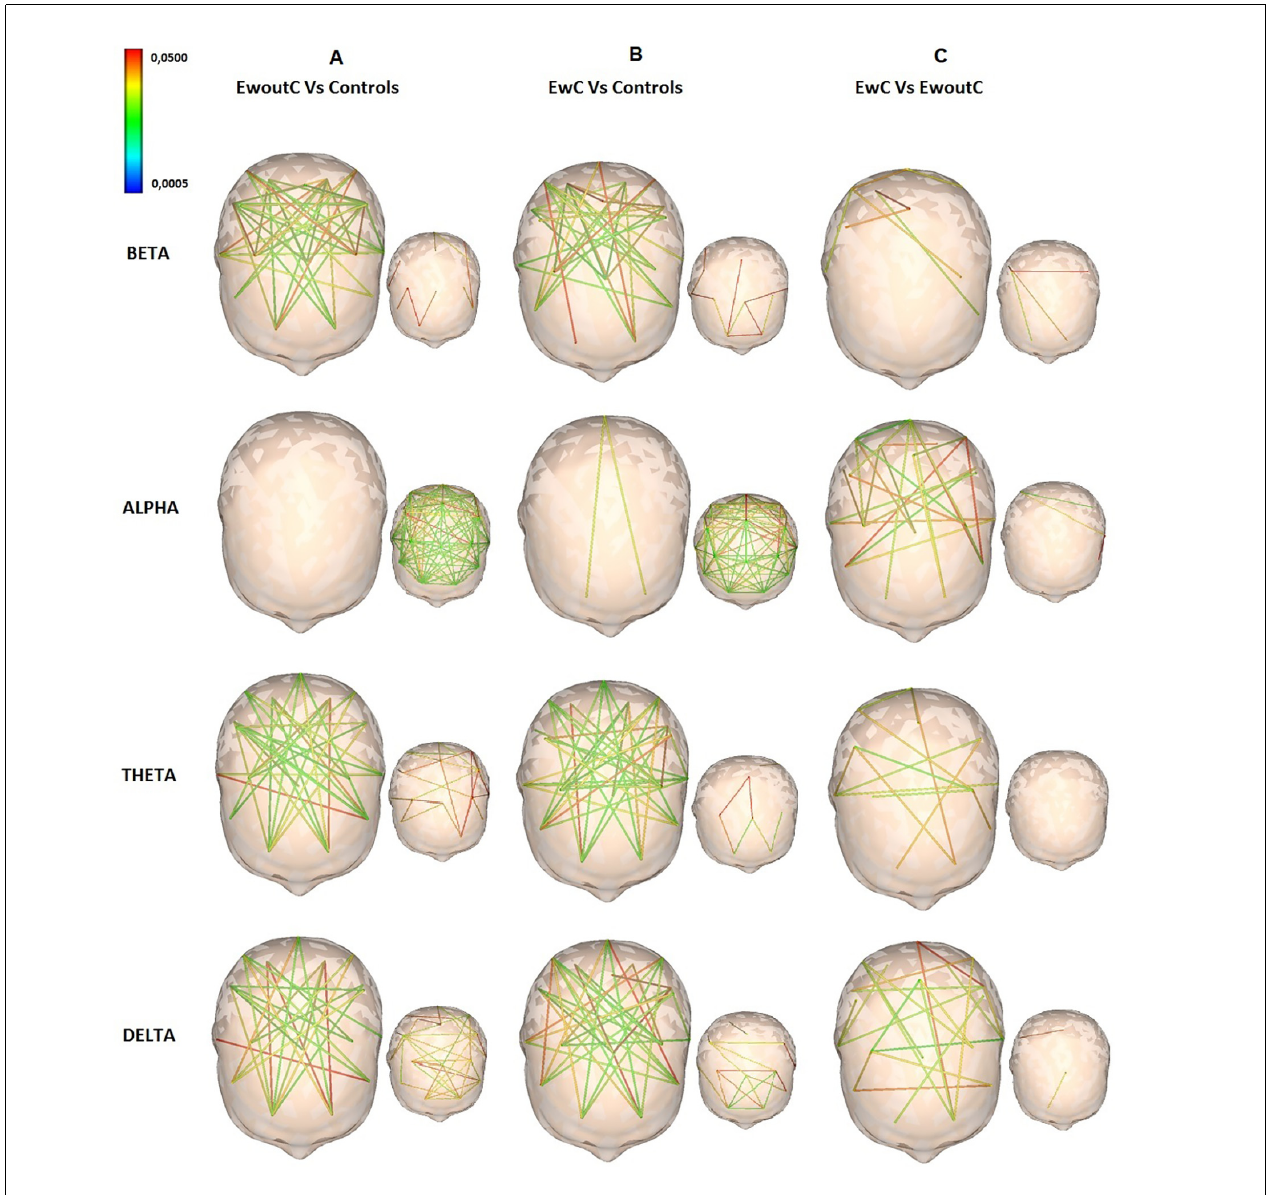
FIGURE 1 | Illustrates pairs of electrodes with significant differences in synchronization likelihood (SL) values between patients and controls in beta, alpha, theta, and delta bands (patients > controls). The colored bar indicates the range of p values, in red representing 0.022 < p < 0.05, yellow 0.011 < p < 0.22, and blue p < 0.001. Differences were distributed over the entire scalp showing strong and significant electrodes SL couplings across all distances. Panel (A) shows an increase of SL in patients with epileptic encephalopathy without cannabidiol Epidiolex (CBD) adjunctive therapy for the beta, theta, and delta frequencies; and a decrease for alpha frequency compared with the control group. Panel (B) presents an increase of SL in patients with epileptic encephalopathy with CBD adjunctive therapy compared with the control group for the beta, alpha, theta, and delta frequencies showing less spatial distribution for alpha frequency. Panel (C) indicates increased synchronization for all frequency bands in patients with epileptic encephalopathy with adjunctive CBD when comparing both patient groups.